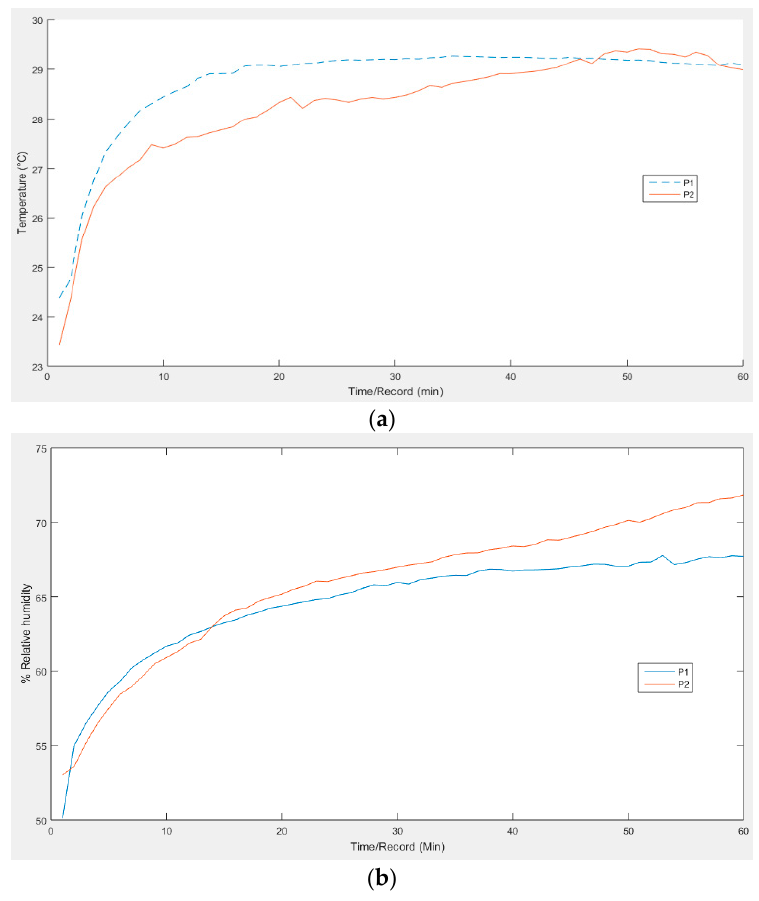
Figure 9. Graph of experimental measurements: ( a ) of temperature; and ( b ) relative humidity. In both temperature and humidity an exponential growth is observed initially.